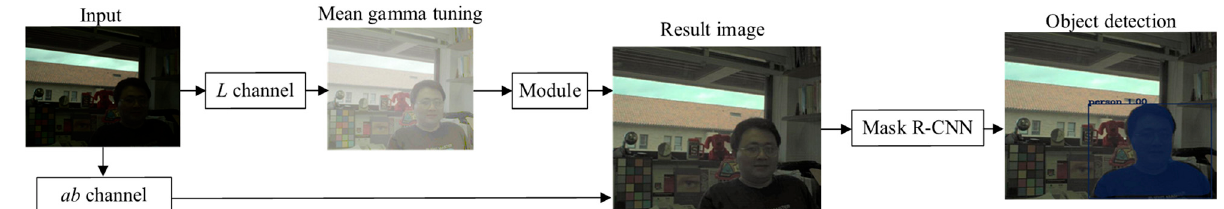
Figure 6. Mask R-CNN processing for closed-circuit television.